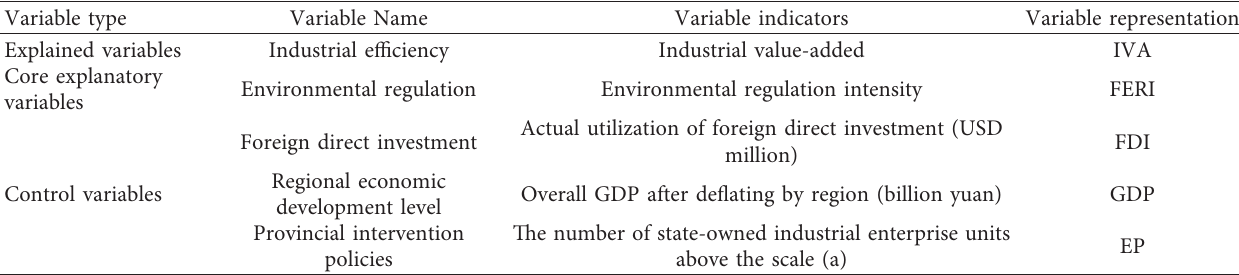
Table 4: Model variable design.